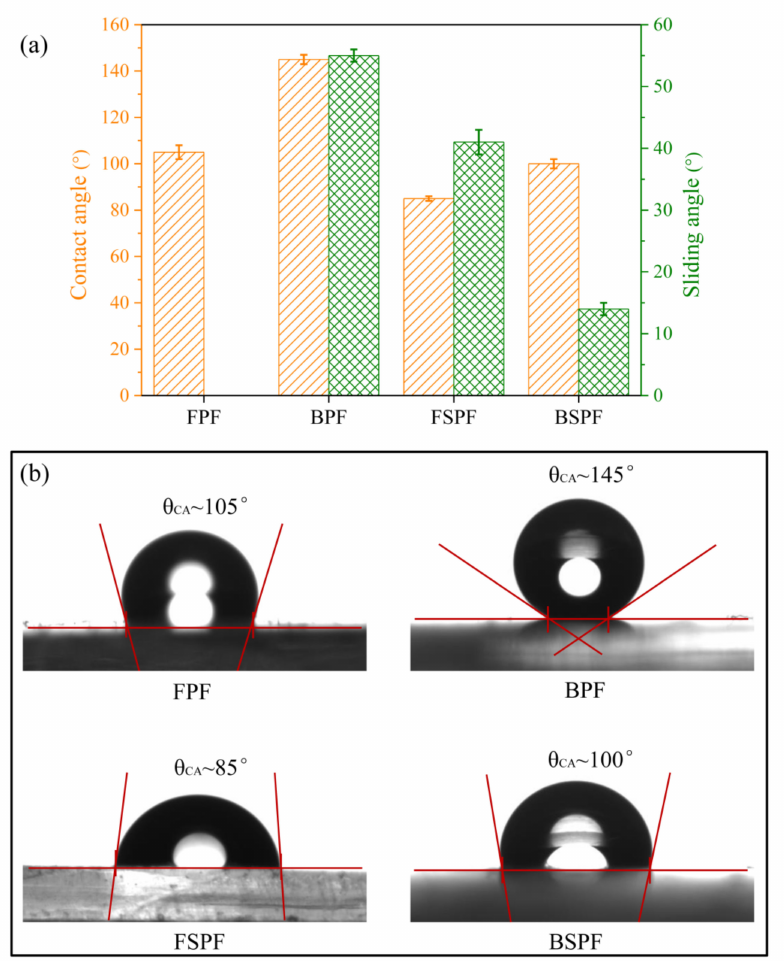
Figure 5. ( a ) θ CA and θ SA measurements of four different surfaces; ( b ) optical images showing a macroscopic water droplet on the corresponding samples, θ CA is a water contact